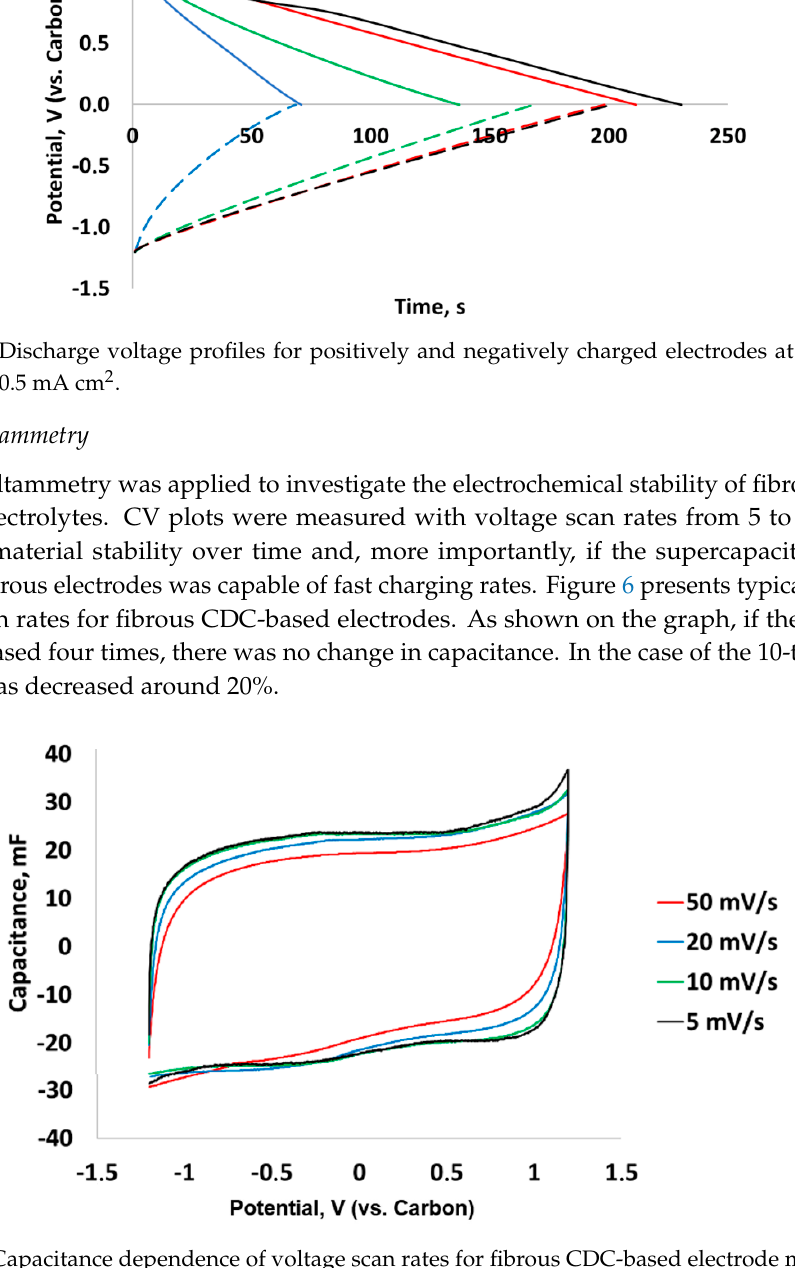
Figure 6. Capacitance dependence of voltage scan rates for fibrous CDC-based electrode material in 1.5 M EMIm-TFSI/ACN electrolyte.